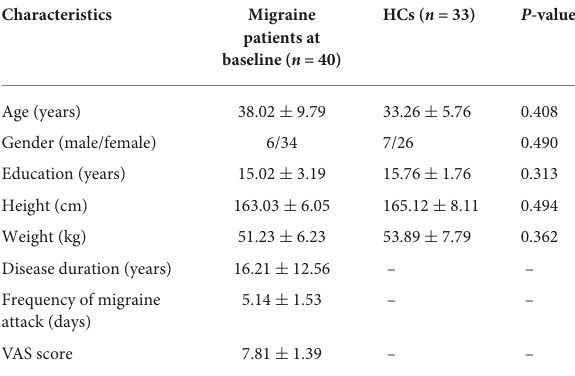
TABLE 1 Demographic and clinical characteristics of patients with migraine without aura and healthy controls at baseline. Characteristics